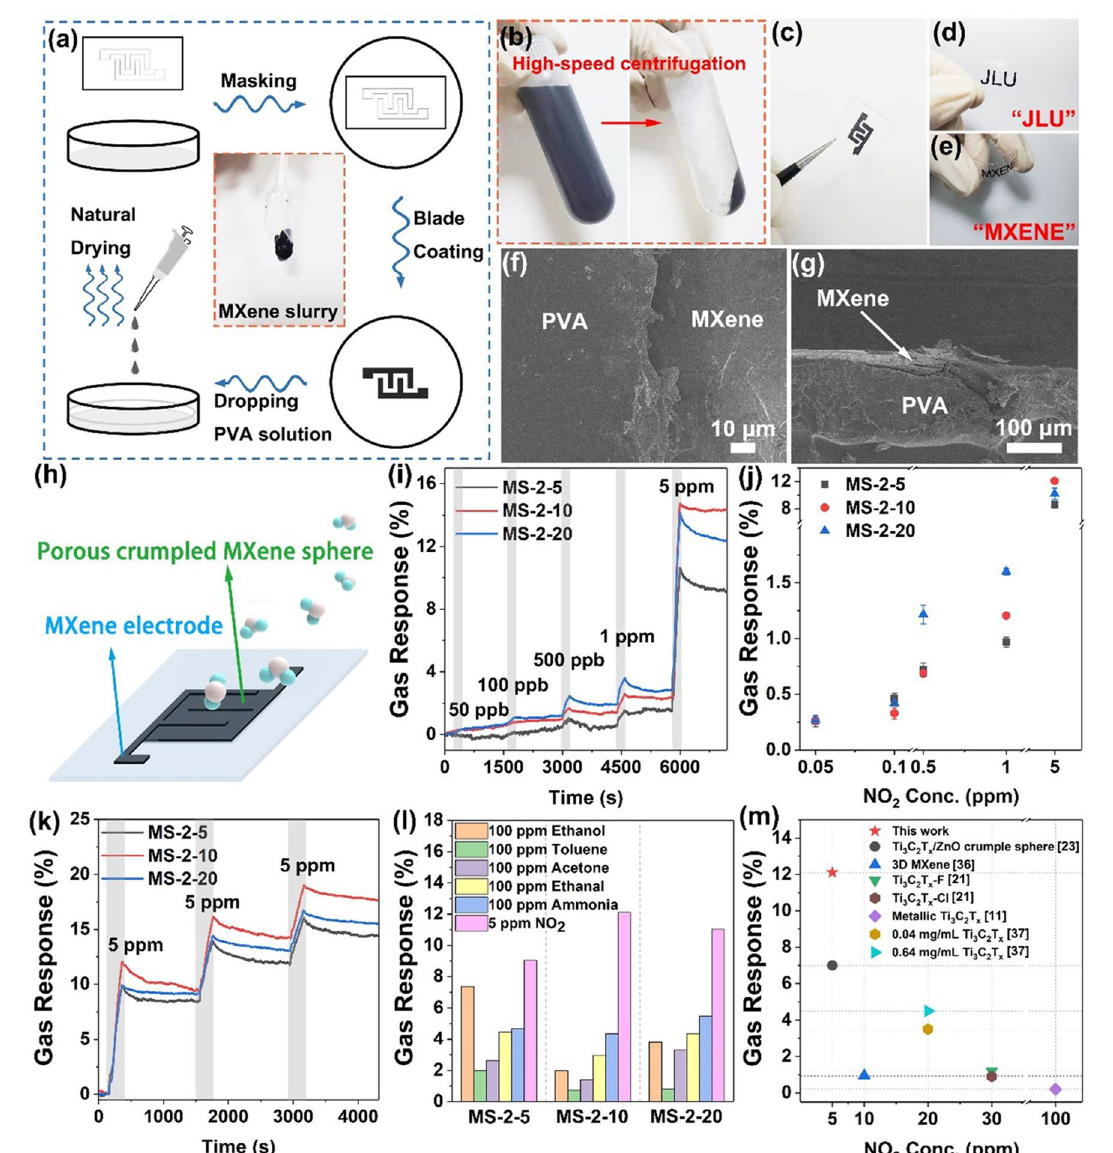
Fig. 3 a Schematic diagram of the fabrication process of the transient PVA substrate with the MXene cross-finger electrode and the photograph of the MXene slurry. b Images of the preparation process of MXene slurry. c Image of the transient PVA substrate with MXene cross-finger electrode. d – e Images of the transient PVA substrate with conductive patterns of “JLU” and “MXENE.” f The frontal SEM image and g the sec- tional SEM image of the PVA substrate with MXene cross-finger electrode. h Schematic diagram of the transient NO 2 sensor based on a porous crumpled MXene sphere. i Dynamic response–recovery curve of sensors based on MS-2-5, MS-2-10, and MS-2-20 in the different concentra- tions of dry NO 2 . j Gas response of sensors based on MS-2-5, MS-2-10, and MS-2-20 depending on NO 2 concentration. k Real-time resistance curve of MS-2-5, MS-2-10, and MS-2-20 in response to 5 ppm of NO 2 for three consecutive times. l The maximum resistance change rate of sensors based on MS-2-5, MS-2-10, and MS-2-20 to 100 ppm of ethanol, acetone, ethanol, toluene, NH 3, and 5 ppm of NO 2 . m Comparison of the performance of MXene-based